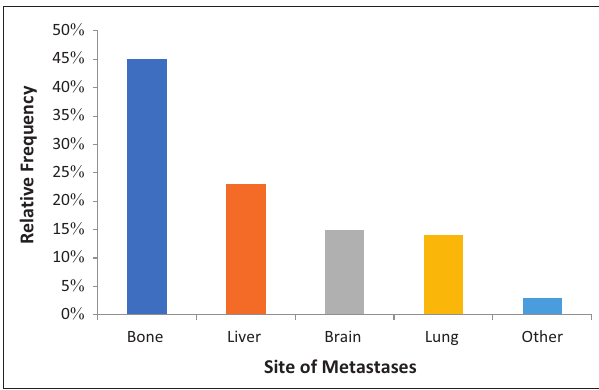
FIGURE 2: Distribution of patients with stage IV disease ( n = 122) according to sites of metastases.